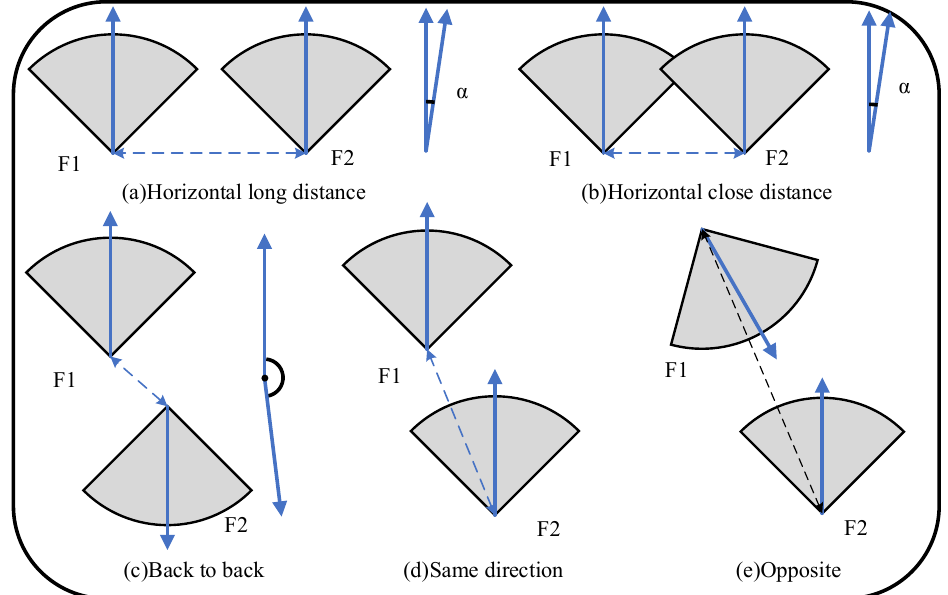
Figure 2. Inter-frame pose relationship. The gray sectors represent the view of the camera, and the arrows in the sectors are their